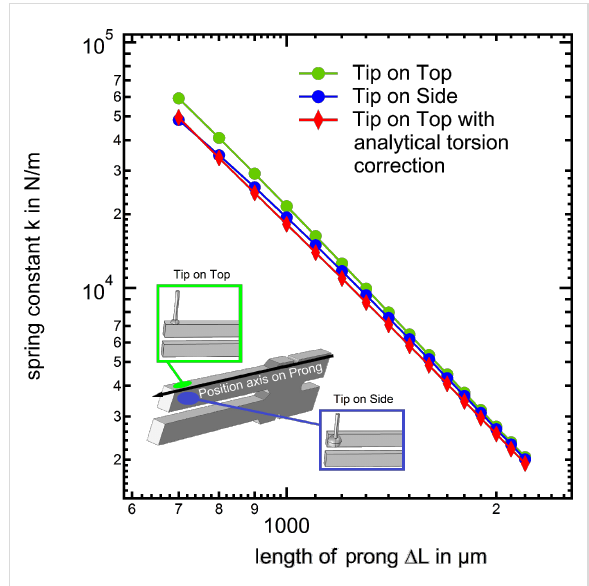
Figure 8: Comparison between tip on side (TOS) and tip on top (TOT) configurations as possible origin of the deviation between FEM Simula- tion and Experiment. The deviation was found to be larger in case of TOT than the contribution of torsion in the TOS configuration.